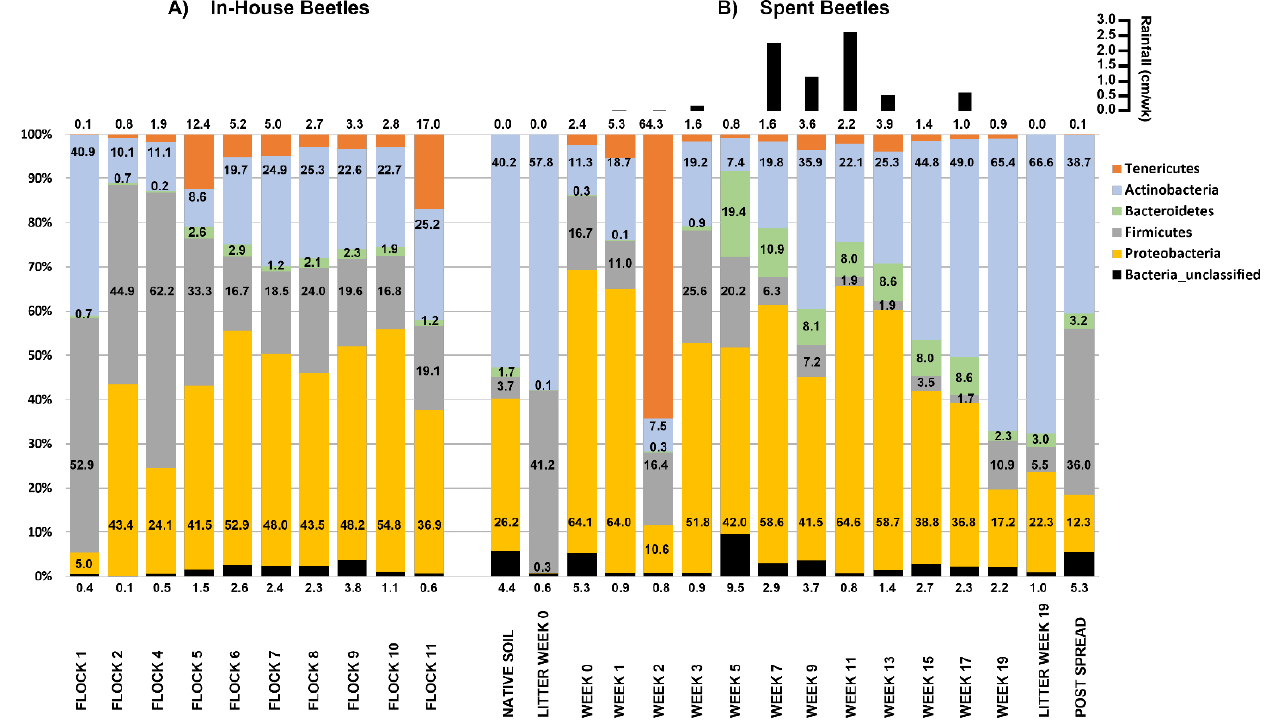
Figure 1. Histograms showing the mean relative abundances of bacterial phyla associated with ( A ) In-House Beetle samples taken during successive flock rotations, and ( B ) Spent Beetles taken after deposition of the litter into pastureland. The values correspond to the percentage of total sequences of that taxon for that sample. In the upper right-hand corner is weekly total rainfall (cm/wk) for weeks 1–3 and Post Spread, and bi-weekly total rainfall for weeks 3–19 at the site until the litter was spread on the field. n = 8 composite samples/Flock and 1 composite sample/Week.